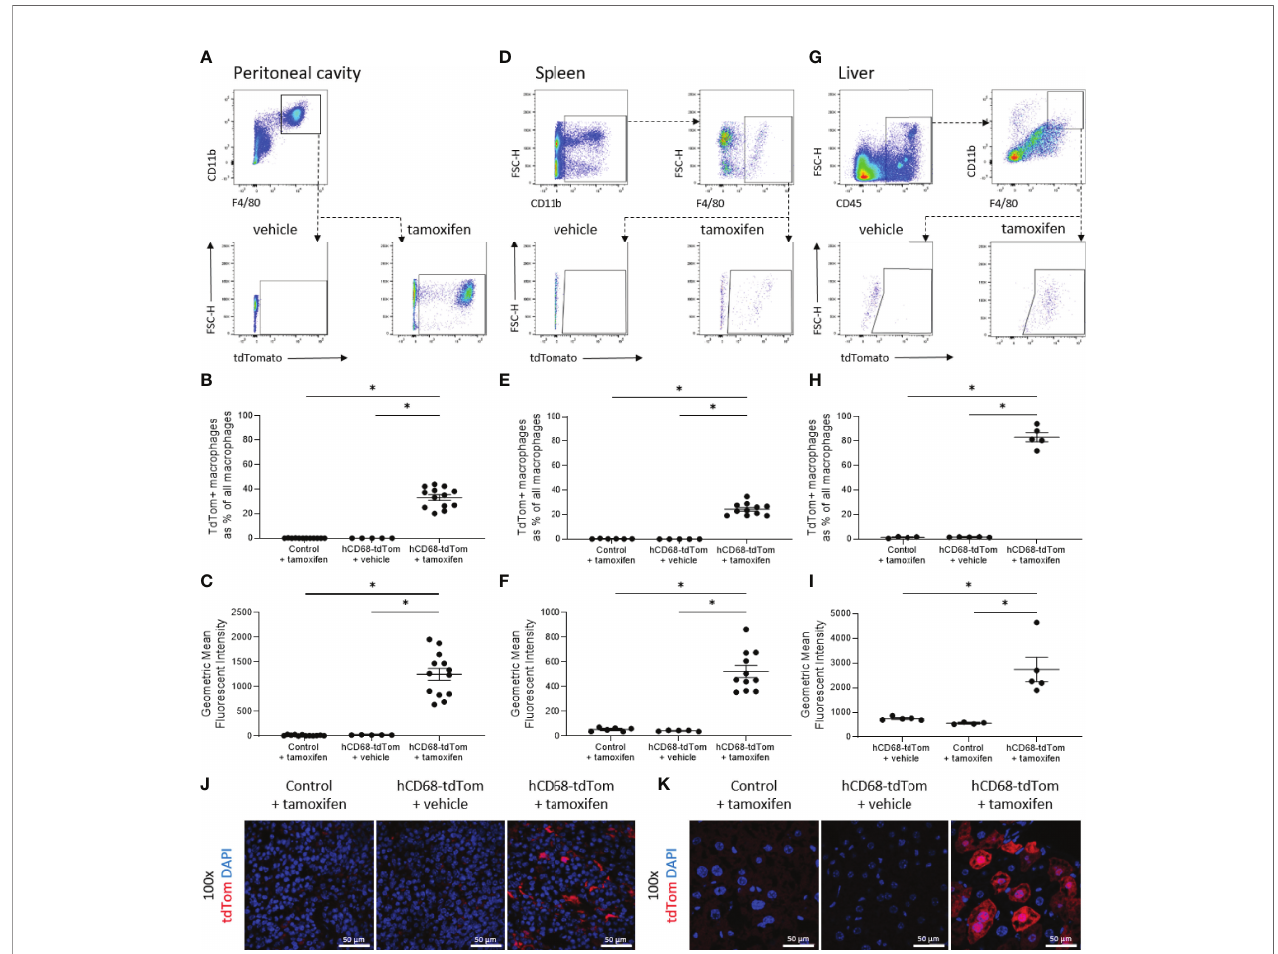
FIGURE 2 | The hCD68 promoter driven inducible Cre recombinase has high activity levels in tissue resident macrophages. Tissue-resident macrophage populations in (A) peritoneal cavity, (D) spleen and (G) liver were de fi ned as CD11b + and F4/80 + cells (gating strategy shown by representative dot plots) with the corresponding frequency of tdTomato-expressing macrophages as a proportion of all macrophages shown in (B) peritoneal cavity, (E) spleen and (H) liver and with respective mean fl uorescence intensity values of tdTomato expression in the whole macrophage population in (C) , (F) and (I) ; one-way ANOVA (* = p < 0.05). Representative immuno fl uorescence images of endogenous tdTomato expression in (J) the spleen and (K) the liver at 100x magni fi cation with DAPI in blue and tdTomato in red; scale bar =